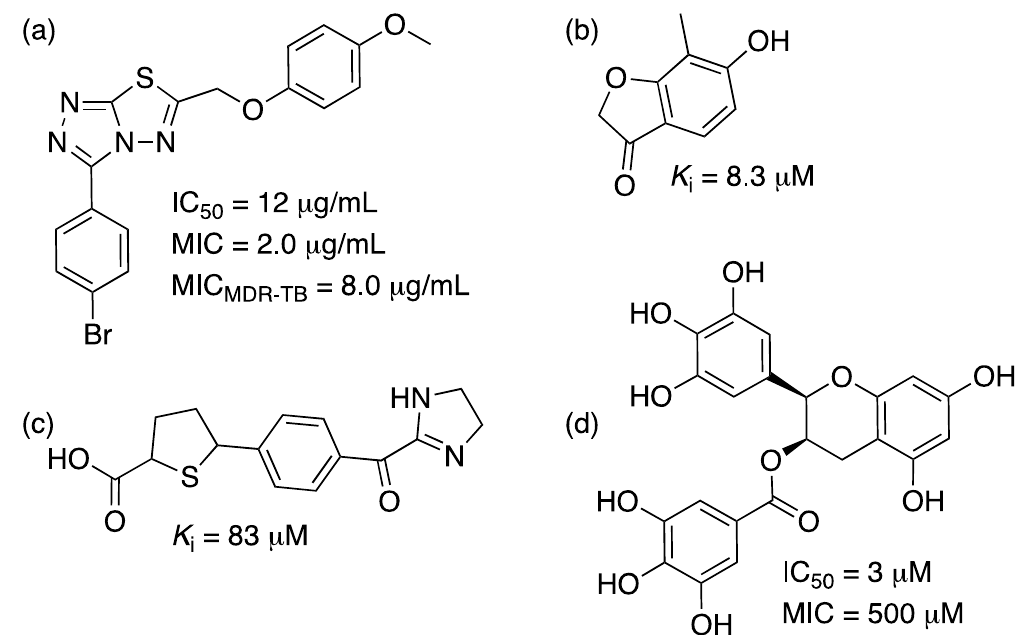
Figure 10. Examples of inhibitors of Mt SD. ( a ) Triazolothiadiazole IMB-SD62, inhibitor of Mt SD, extracted from Li and coworkers [111,113]. ( b ) and ( c ) S. aureus SD inhibitors extracted from Enríquez-Mendiola and coworkers [110]. ( d ) Polyphenolic, inhibitor of P. putida SD, extracted from Peek and coworkers [108].